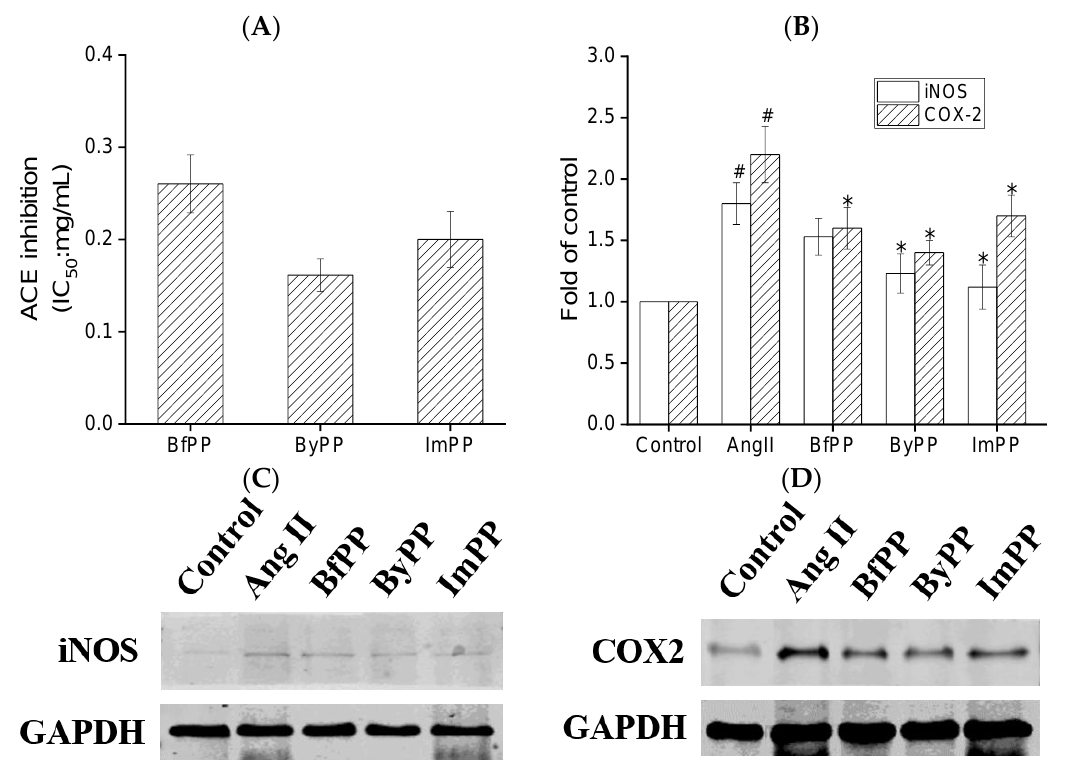
Figure 4. Effect of beef and PBMA hydrolysates prepared by gastrointestinal digestion on ACE inhibitory and anti-inflammatory activities. ( A ) In vitro ACE inhibition, and ( B – D ) the expressions of iNOS and COX-2 after co-treatment with 1 µ M Ang II and hydrolysates for 24 h in A7r5 cells. The data are represented as means ± SD; # represents p < 0.05 vs. control group. * represents p < 0.05 vs. Ang II group.